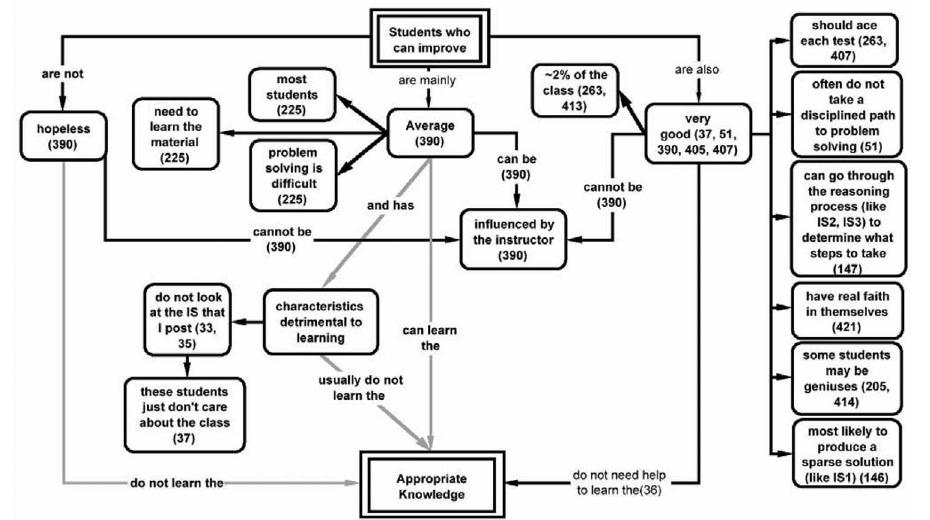
FIG. 3. Child map of instruc- tor 3 for the principal category of “Students Who Can Improve.”